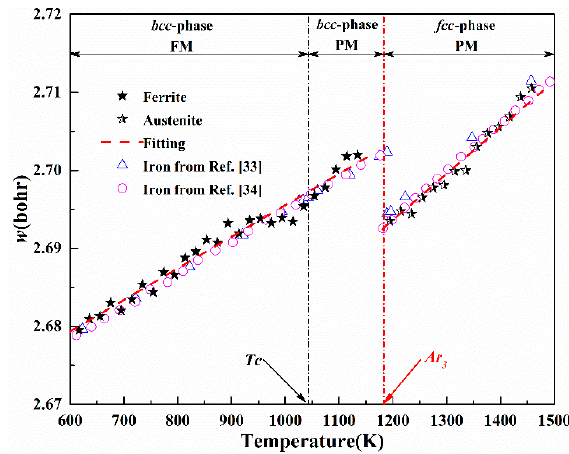
Figure 4. Wigner–Seitz radius w of single bcc-phase and fcc-phase as a function of temperature. Experimental data of lattice parameter measurements (open symbols) from References [33,34] are taken. Solid symbols show the dilation test temperature dependencies of the Wigner–Seitz radius for single bcc-phase and fcc-phase, from left to right, and their linear regressions are plotted with red dashed lines.